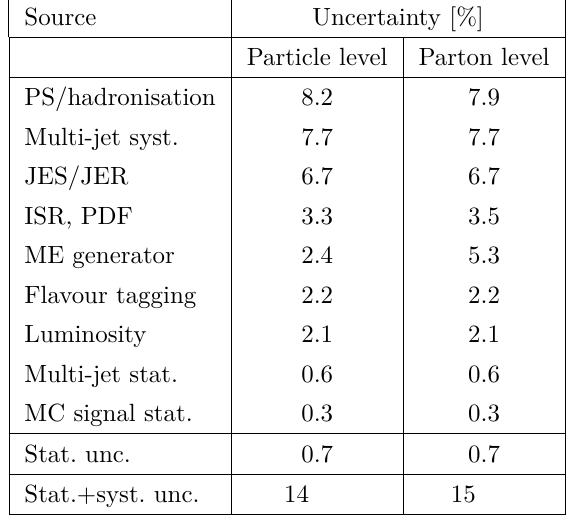
Table 7 . Summary of the main relative uncertainties in the inclusive cross-section measured at the particle and parton levels. The uncertainties are